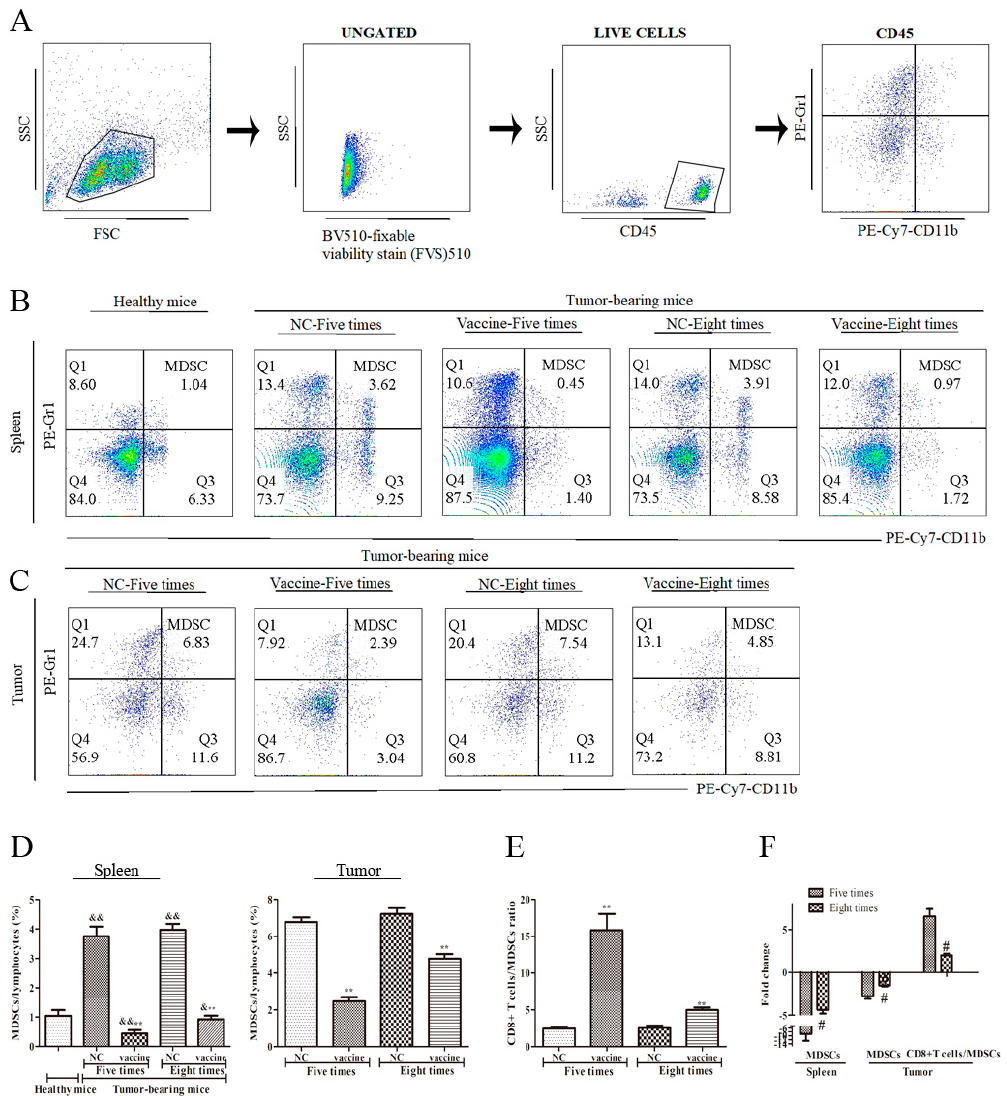
Figure 5. The e ff ect of immunization cycles on the recombinant MUC1-MBP vaccine-induced myeloid-derived suppressor cells (MDSCs) in the spleen and the tumor microenvironment. ( A – D ) Mice were euthanized 15 days after tumor inoculation, and splenic mononuclear cells from each group were stimulated in vitro with a cocktail (2 µ L / mL) for 5 h. Then, the cells were stained with BV510-conjugated anti-fixable viability stain 510, PE-conjugated anti-Gr1 and PE / CY7-conjugated anti-CD11b Abs. ( A ) Dot plots showing the gating strategy. ( B , C ) The percentage of MDSCs in the spleen and the tumor microenvironment is shown in the dot plots of flow cytometry data. ( D ) The percentage of MDSCs in the spleen and the tumor microenvironment is shown in the data table. ( E ) The CD8 / MDSC ratio in the tumor microenvironment following immunization with the recombinant MUC1-MBP vaccine. ( F ) Fold change (CF) represents the ratio of the experimental group to the NC group. Increased fold change = the experimental group / NC group and decreased fold change = − [NC group / the experimental group]. && p < 0.01 vs. healthy mice * p < 0.05, ** p < 0.01 vs. the NC group. # p < 0.05 vs. the group immunized five times.